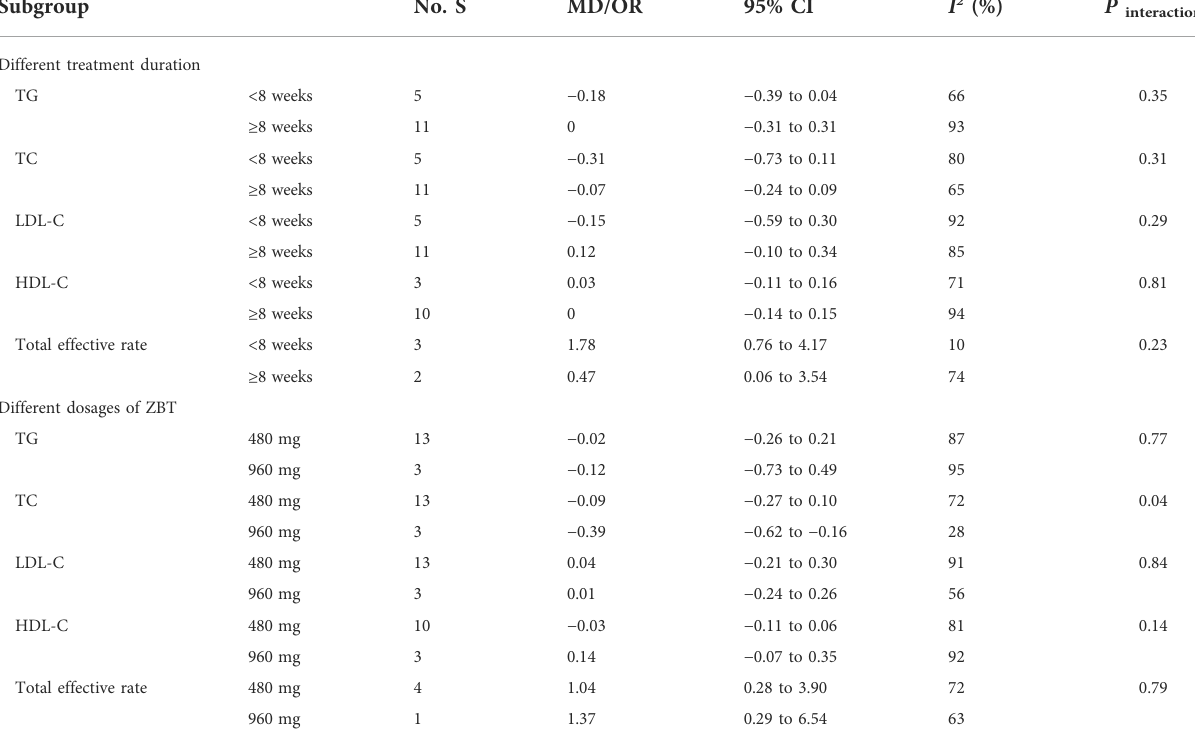
TABLE 4 Subgroup analysis of the main ef fi cacy outcomes of ZBT vs. CT.